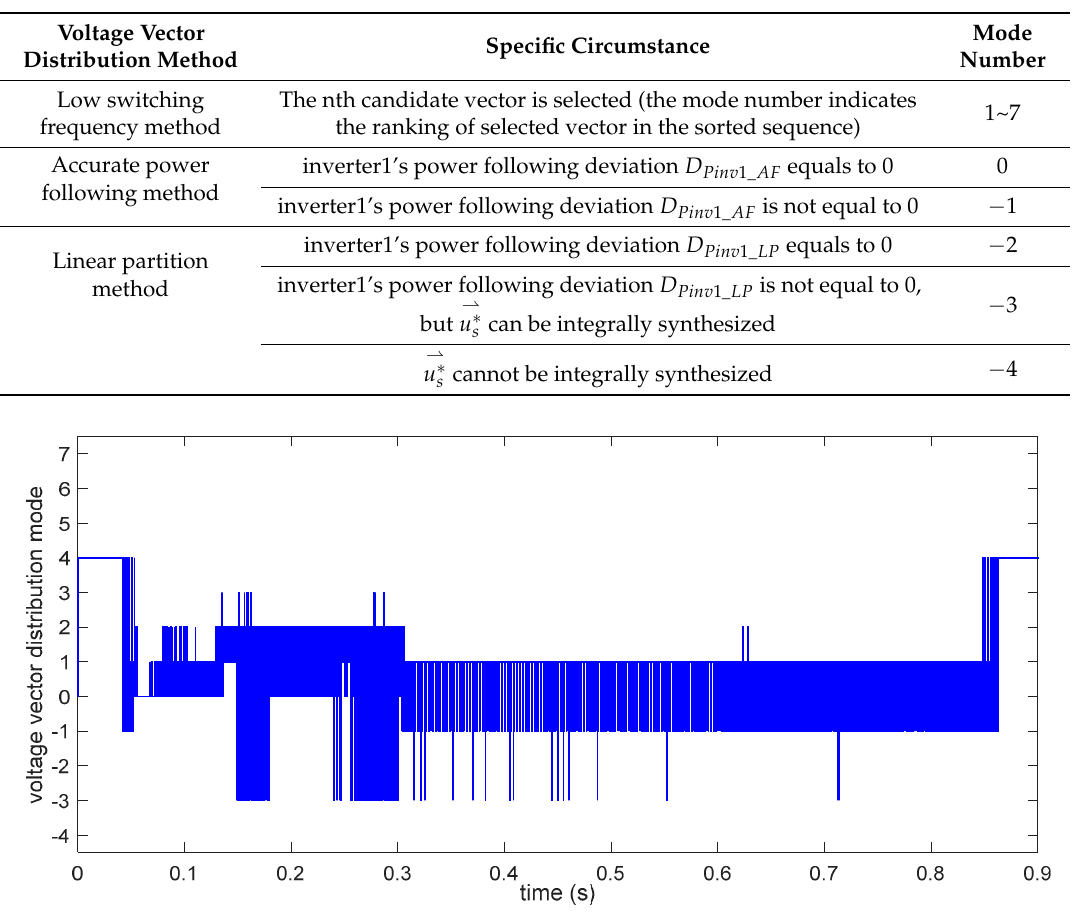
Figure 15. Curve of voltage vector distribution mode number.